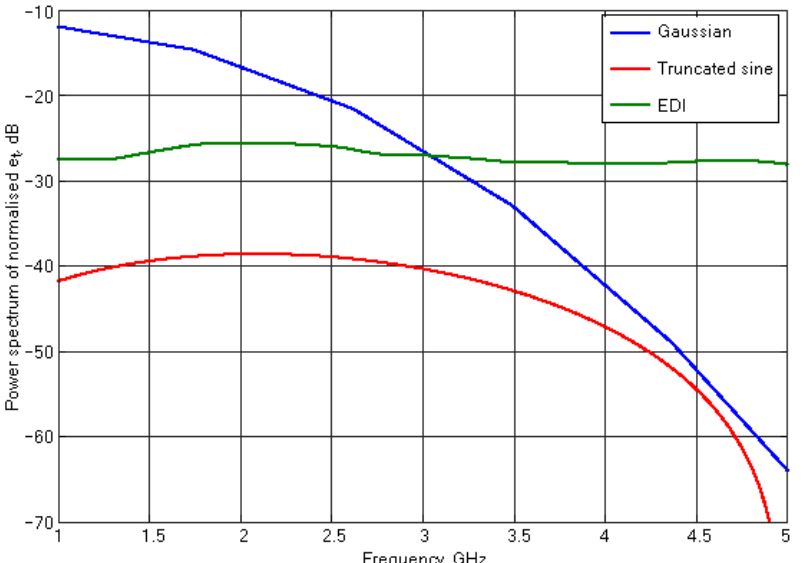
Figure 6. Power spectra of normalized simulation signals: (a) blue line—Gaussian signal SetGaussEx- cite ( FDTD , 1e9, 2.5e9 ); (b) red line—truncated sine signal; (c) green line—signal of EDI